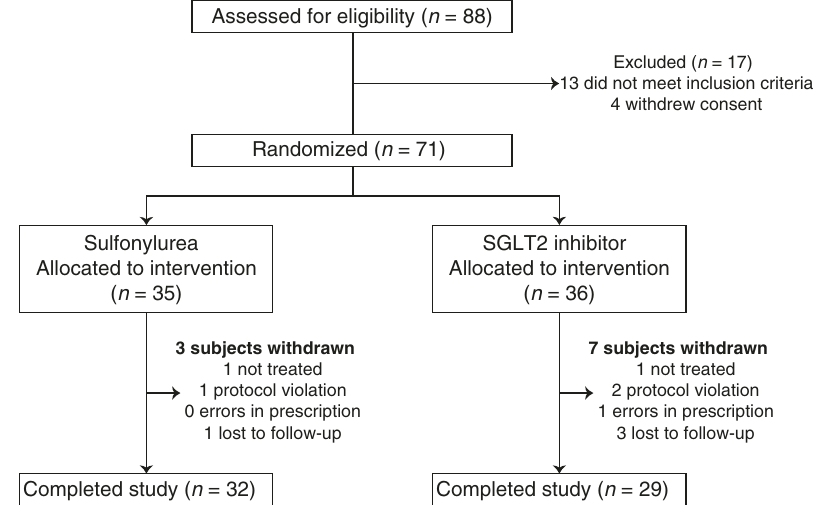
Fig. 1 Participant fl ow diagram. Numbers of participants who were initially screened, underwent random allocation, withdrew, and were included in the fi nal analysis. SGLT2 sodium – glucose cotransporter